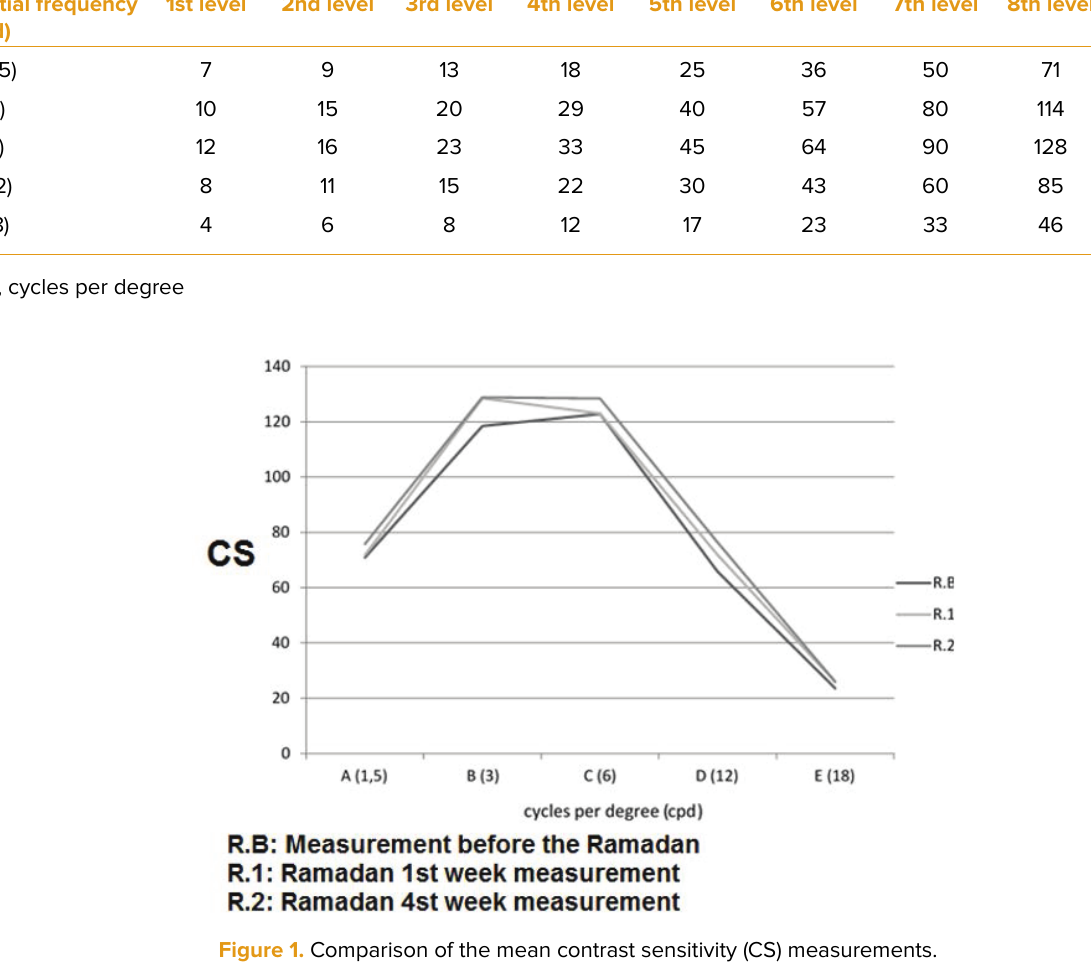
Figure 1. Comparison of the mean contrast sensitivity (CS)